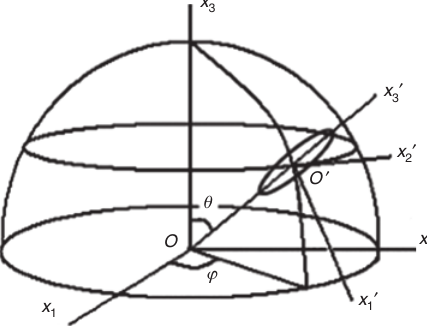
Figure 2: Schematic illustration of the global and local coordinate